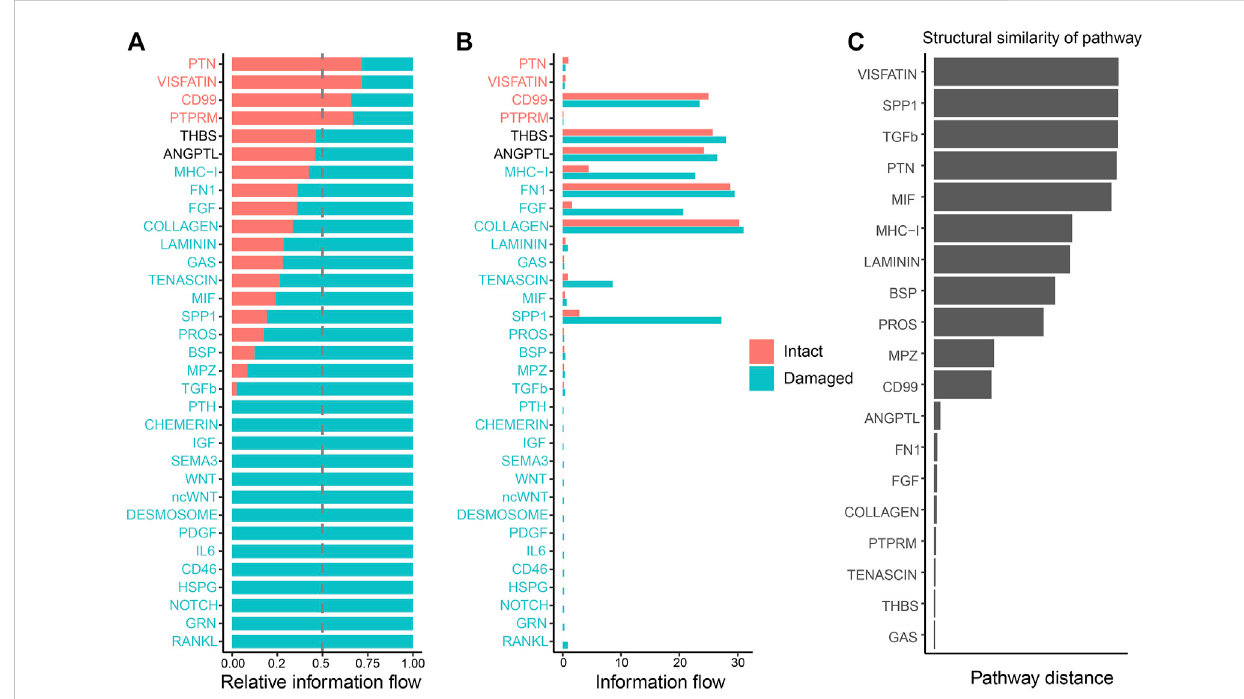
FIGURE 5 Cellular communication changes mediated by signaling pathways in osteoarthritis between the intact and damaged cartilage groups. (A) Bar chart showing the difference in the relative ratio of information fl ow in the interaction network between the intact and damaged cartilage samples. (B) Information fl ownumbersbetweentheintactanddamagedcartilagesamples.Thetopsignalingpathways,markedwithredcoloratthetop,areenriched in the intact cartilage samples, while green color-labeled signaling pathways are enriched in the damaged cartilage samples. The middle pathways marked in black are equally enriched in the two groups. (C) Degree of signaling pathway differences between intact and damaged cartilage samples by pairwiseEuclideandistance.TheWilcoxontestwasusedtodeterminewhetherasigni fi cantdifferencebetweenthetwogroups. p -values < 0.05indicated a statistically signifcant